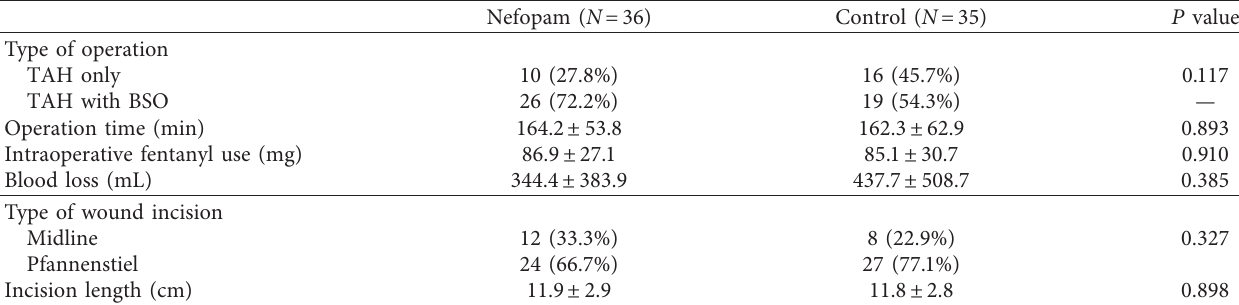
Table 2: Intraoperative characteristics.